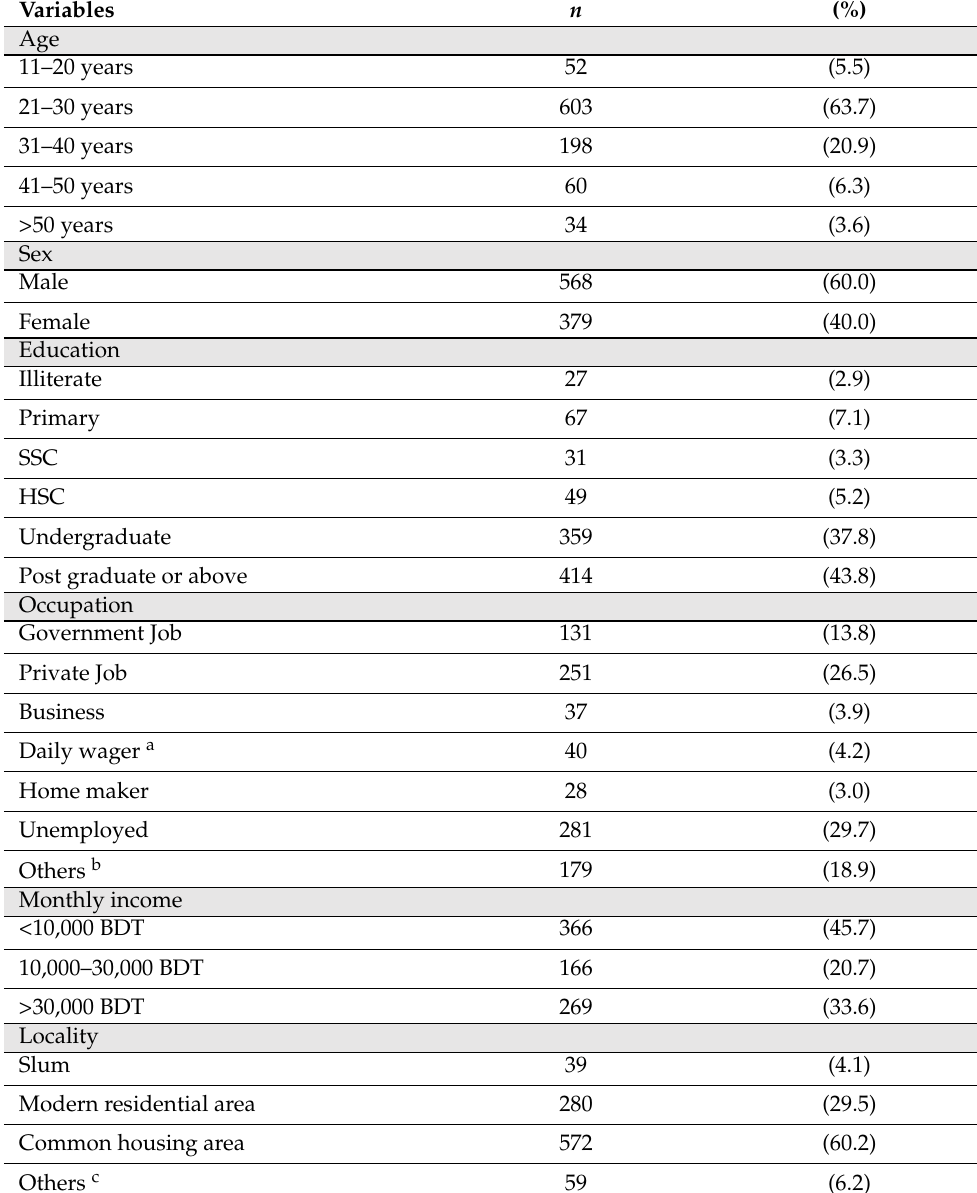
Table 1. Socio-demographic profile of the study